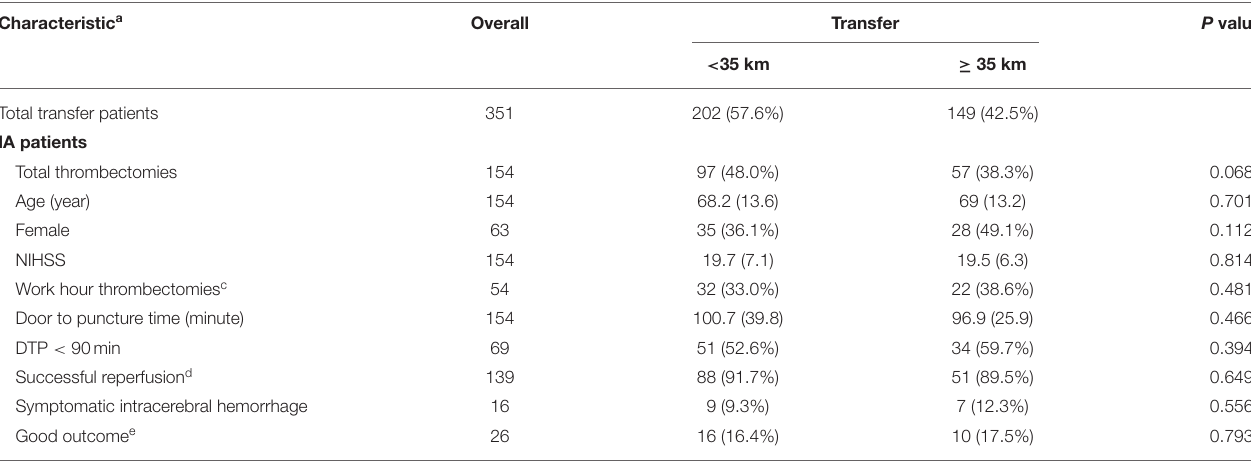
TABLE 3 | Characteristics of study population stratified by transfer distance. Characteristic